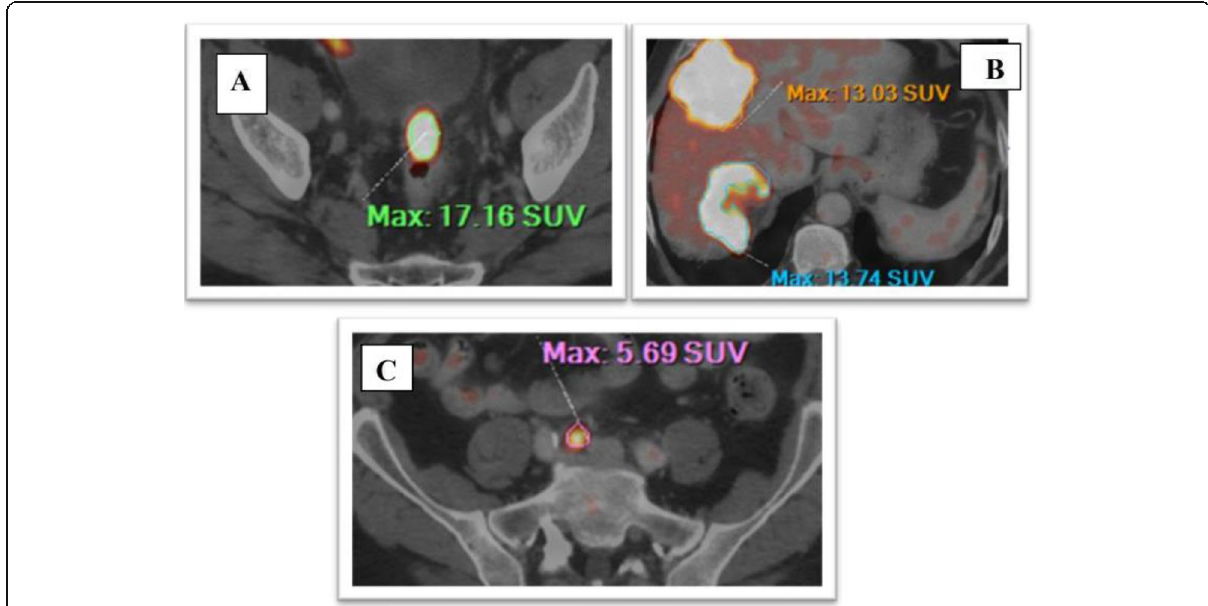
Fig. 5 A 65-year-old male patient with a history of rectal cancer treated first surgically followed by chemotherapy. He was presented with elevated CEA and referred for PET/CT assessment. a , b , c Axial PET/CT images through the abdomen and the pelvis showing the following: recurrent hypermetabolic soft tissue nodule at the pelvic operative bed achieving activity about 17.16 SUV max ( a ); hypermetabolic hepatic focal lesions achieving about 13 and 13.7 SUV max ( b ); hypermetabolic right internal iliac lymph nodes achieving activity about 5.69 SUV max ( c )